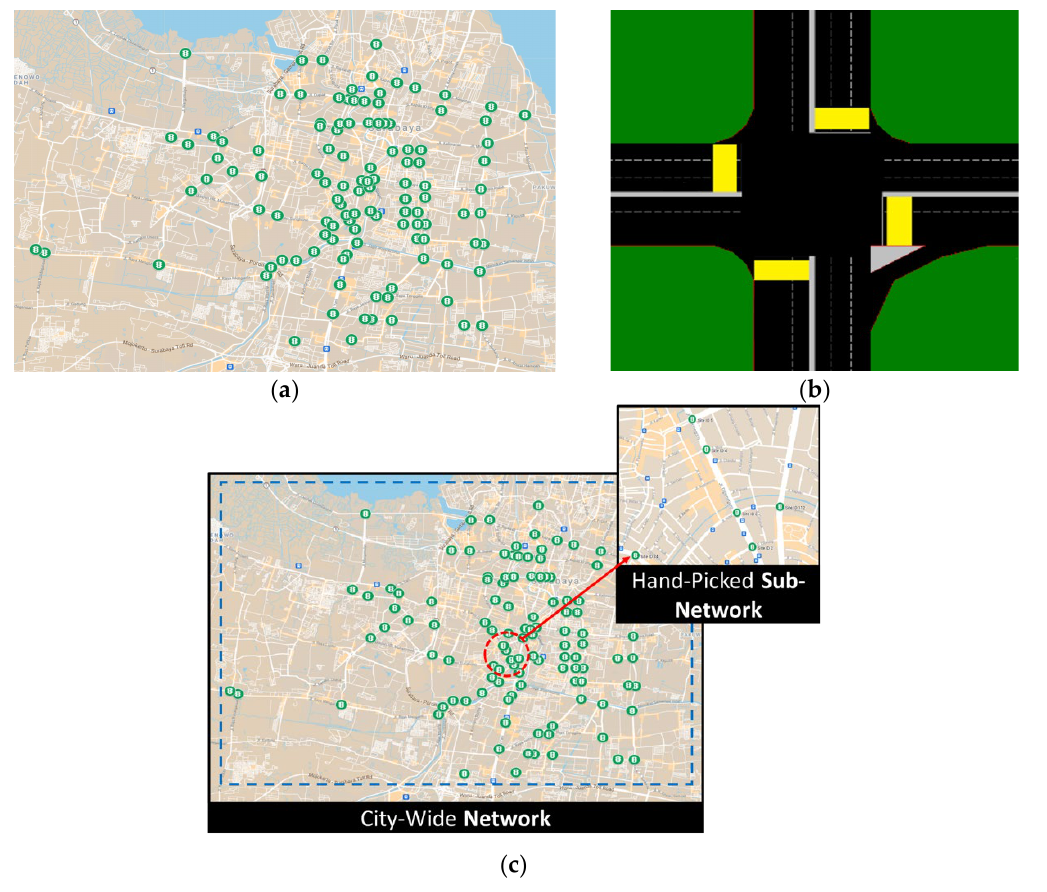
Figure 4. Maps of 115 intersections equipped with working vehicle detectors located in the urban network of Surabaya, Indonesia. Every traffic light symbol in ( a ) represents one intersection. Every intersection usually consists of 3–4 vehicle detectors. The placement of vehicle detectors in an intersection is shown in ( b ), where each yellow square represents one vehicle detector that counts vehicles leaving an intersection. Part ( c ) compares the city-wide network (blue dashed area) with the hand-picked sub-network (red dashed area).